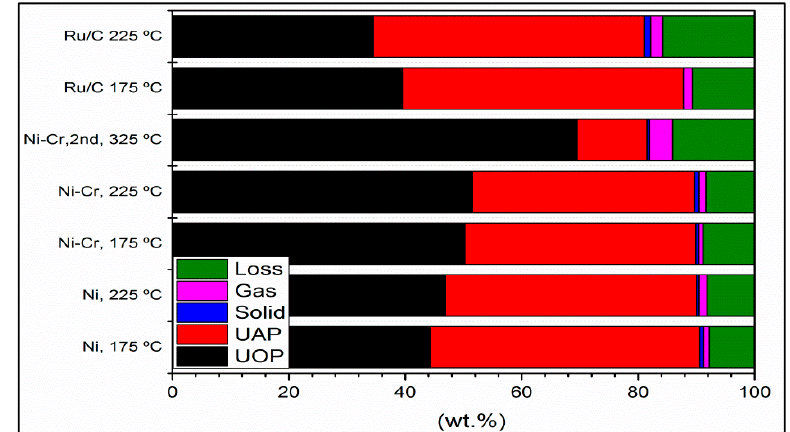
Figure 1. Product distribution after the first upgrading of beech wood fast pyrolysis bio-oil (BWBO) at 175 ◦ C and 225 ◦ C with Ni, Ni–Cr, and Ru / C catalysts. The second upgrading of a previously upgraded beech wood fast pyrolysis bio-oil (UBWBO) is presented and referred to as Ni–Cr, 2nd ,325 ◦ C , considering the upgrading temperature of 325 ◦ C with the Ni–Cr catalyst. Upgraded aqueous phase is referred to as UAP and upgraded oil phase is referred to as UOP.